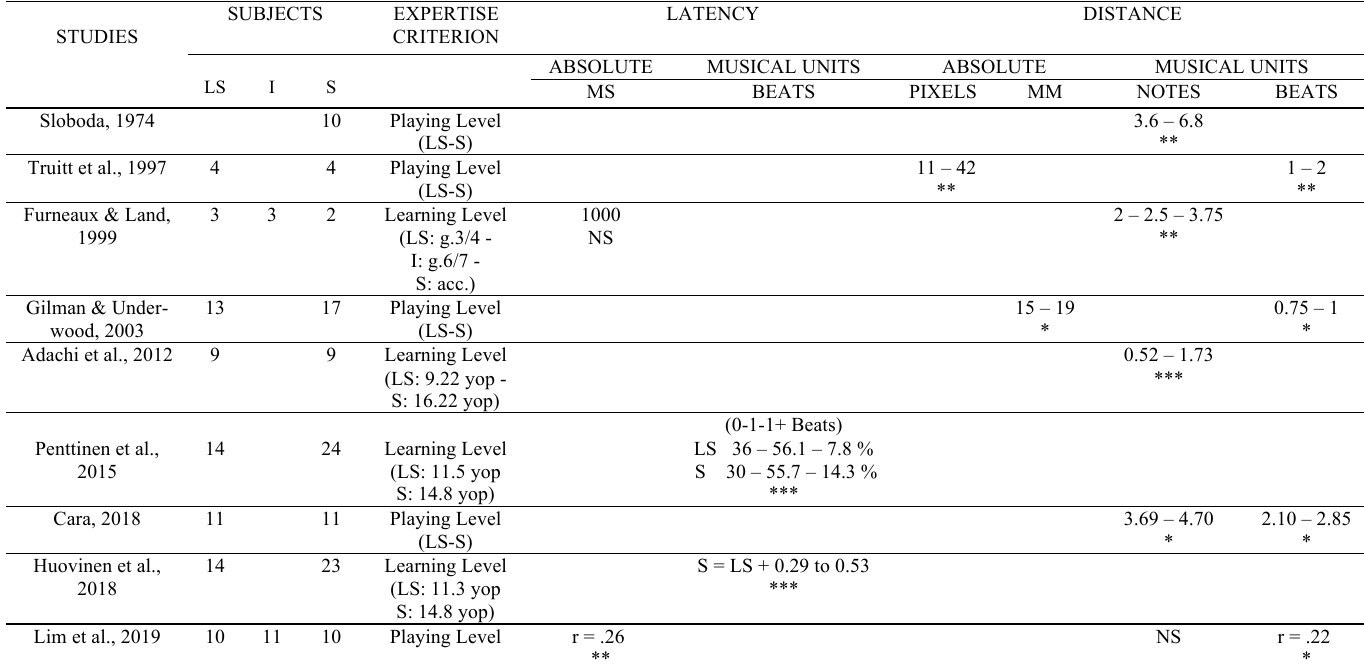
Table 3. Eye-Hand Span as a function of expertise